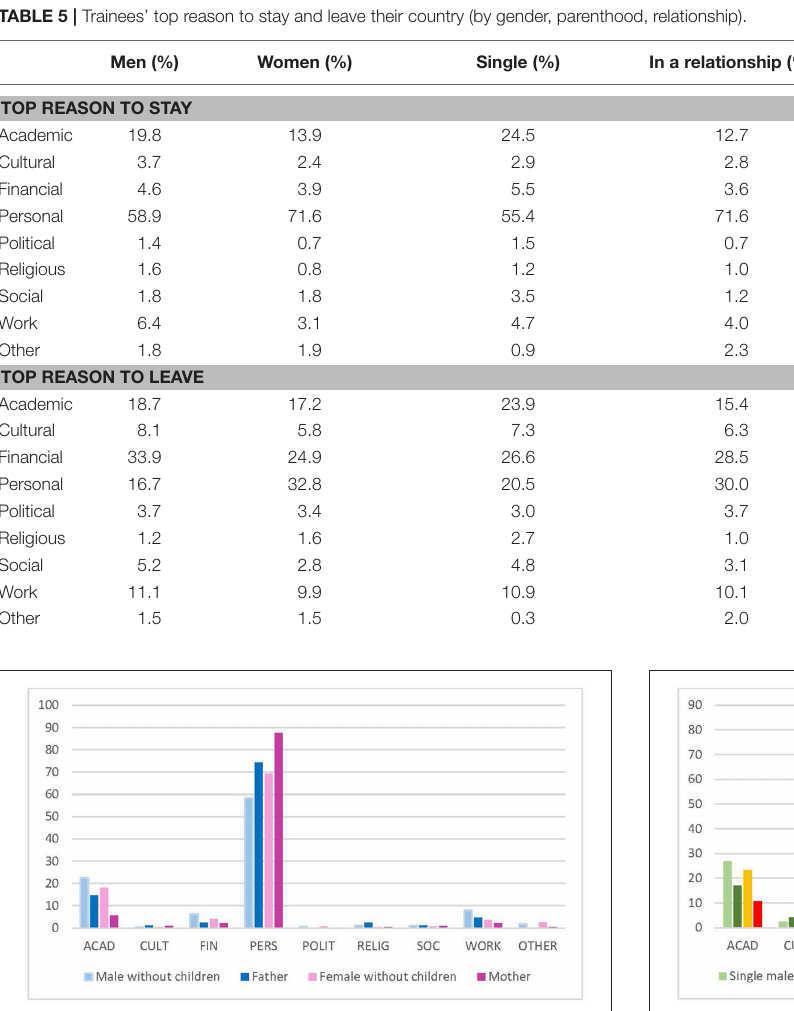
FIGURE 4 | Top reason to stay (gender and relationship) (%). ACAD, academic; CULT, cultural environment; FIN, financial; PERS, personal; POLIT, political; RELIG, religious; SOC, social. Data reported in %.